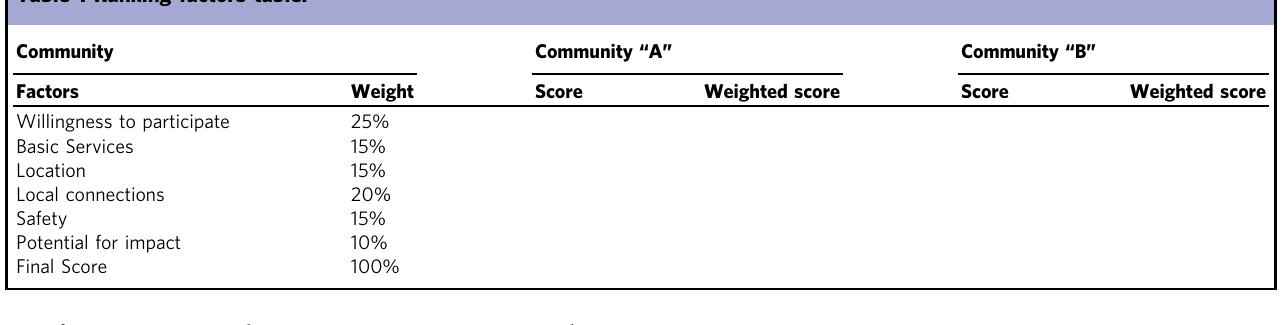
Table 2 Proposed key factors and component